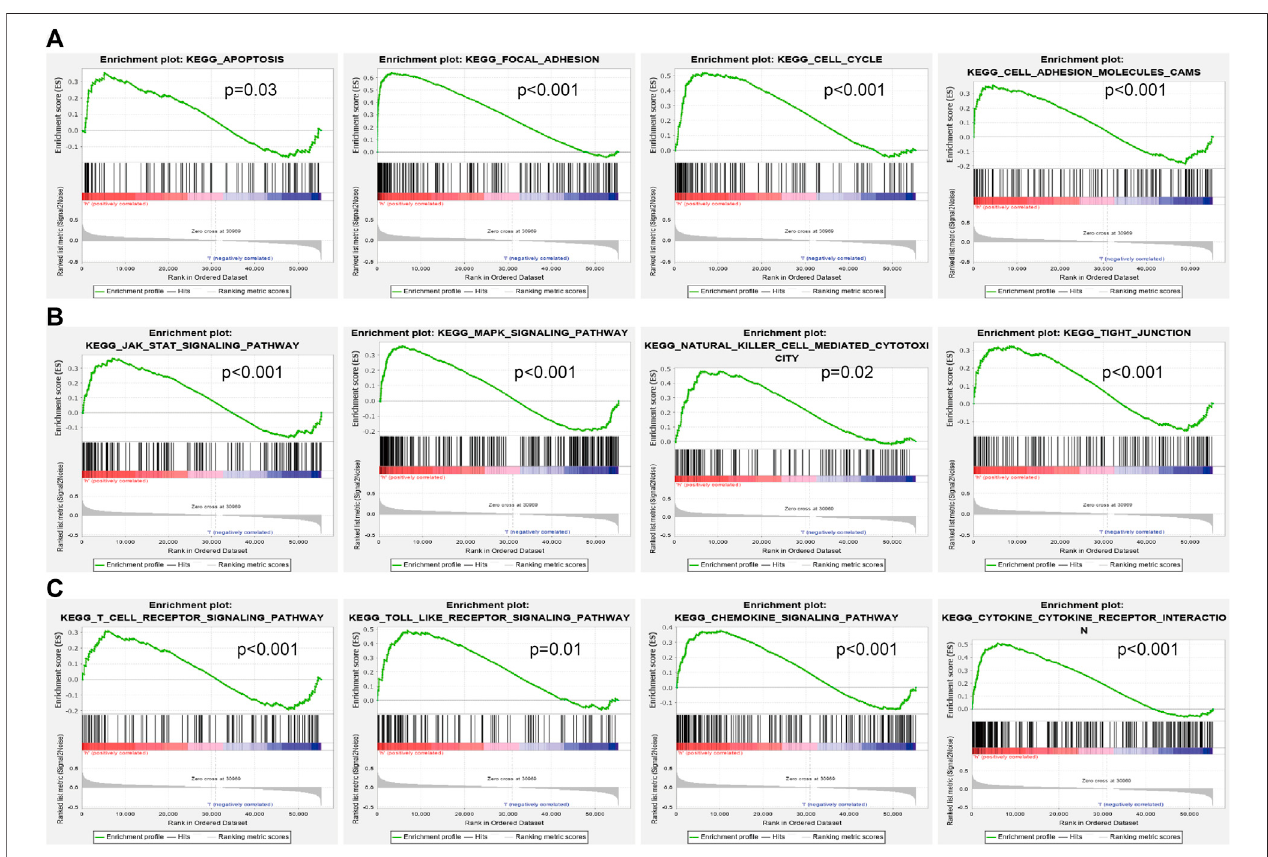
FIGURE 6 | Identi fi cation of lncRNA-AP000695.2-related signaling pathways in lung adenocarcinoma. (A – B) Top 12 signi fi cant KEGG pathways associated with AP000695.2 were examined by GSEA